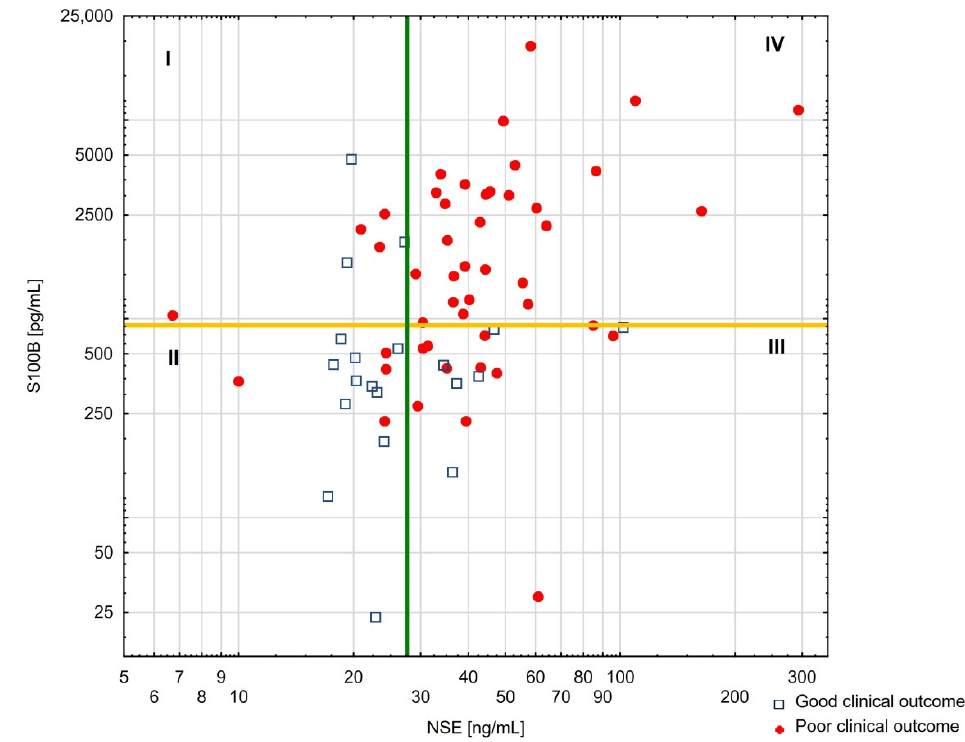
Figure 3. Multimodal prognostication of poor clinical outcomes with both S100B and NSE levels measured at admission. Previously reported cut-off values for S100B (696 pg/mL) and NSE (27.6 pg/mL) levels were marked to divide patients into four quadrants I–IV. Blue squares—good clinical outcome (CPC 1–2). Red dots—poor clinical outcome (CPC 3–5 or death). Abbreviations: CPC—cerebral performance category; NSE—neuron-specific enolase.